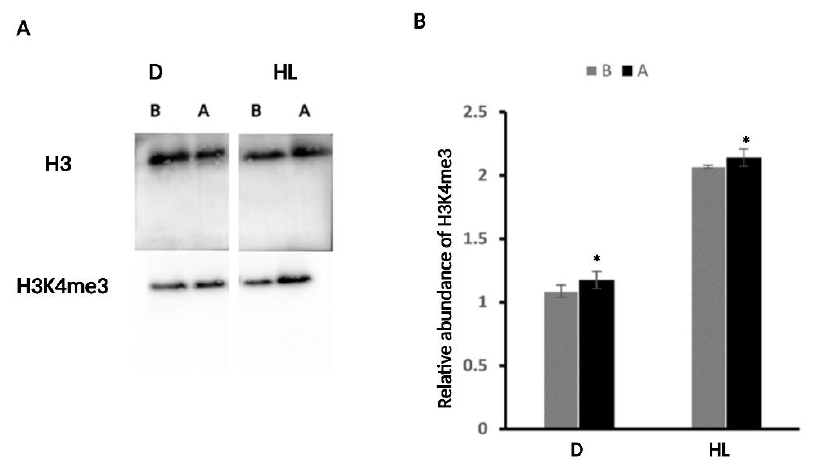
Figure 8. H3K4me3 increased in response to D and HL. ( A ) Immunoblot of WT plants stressed with D and HL at 3 weeks old. B = before stress A = after stress. Histone extracts were probed with H3K4me3-specific antibodies, and H3 was used as loading control. ( B ) Densitometric analysis performed by Bio-Rad Image Lab Software 5.1 and shows the relative expression of H3k4me3 in B and A samples. Relative expressions were obtained from three independent replicates with SD values, but the blot shown is from one replicate. The other two replicates can be found in Supplementary Figure S12. Significant differences were analyzed by t- test, * p < 0.05.